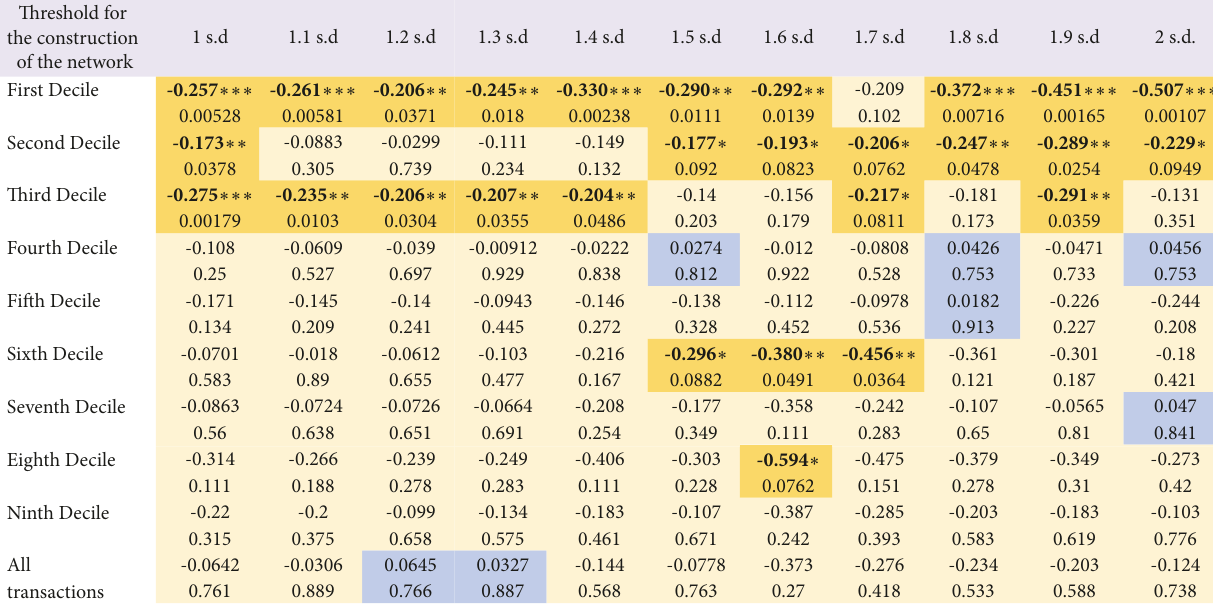
Figure 1: Estimated coefficients associated with the positive spatial dependence variable in Probit regressions with different thresholds defining the transaction network and different sizes of the IPSA shock used as the dependent variable in the Probit. Each regression controls for the variation of oil prices, dollar prices, VIX index, emerging market index, copperprices, 5-year credit default swaps S&P 500 stockindex, month, and year. The size of the IPSA jump is measured in standard deviations